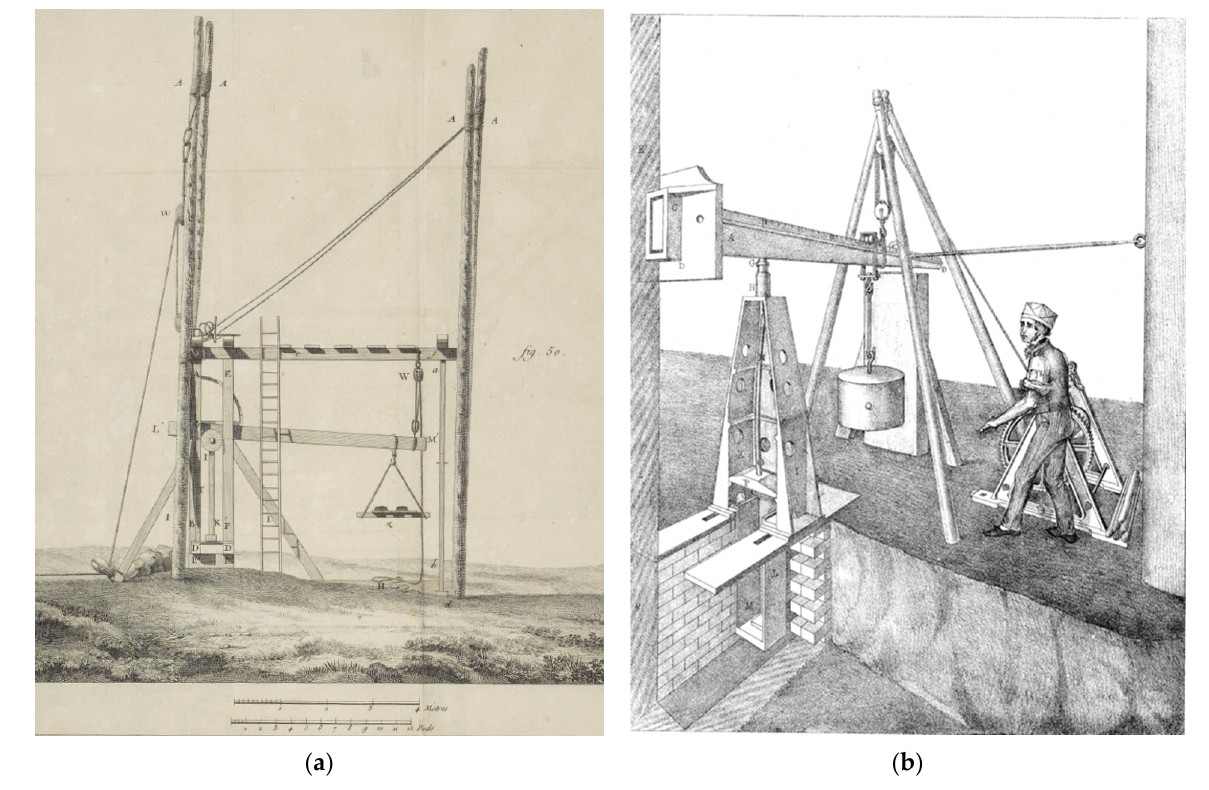
Figure 2. Examples of late 18th/early 19th century on-site testing machines for determining the compressive breaking loads of pillars (rods) of cast iron, steel and timber. ( a ) From [42]; ( b ) from [48].